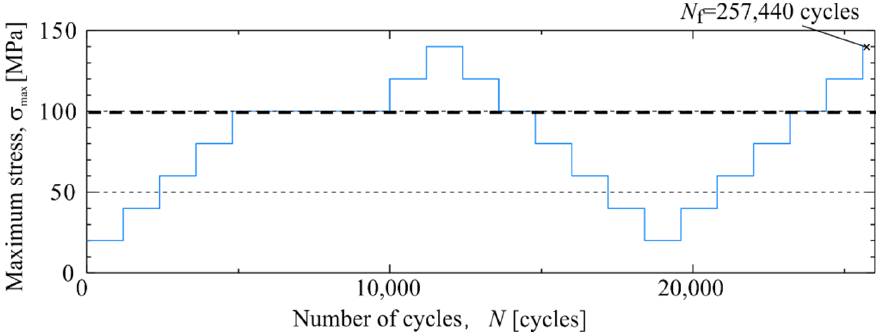
Figure 11. Change of maximum stress applied to the SCFRP specimen during the staircase-like stress level tests.